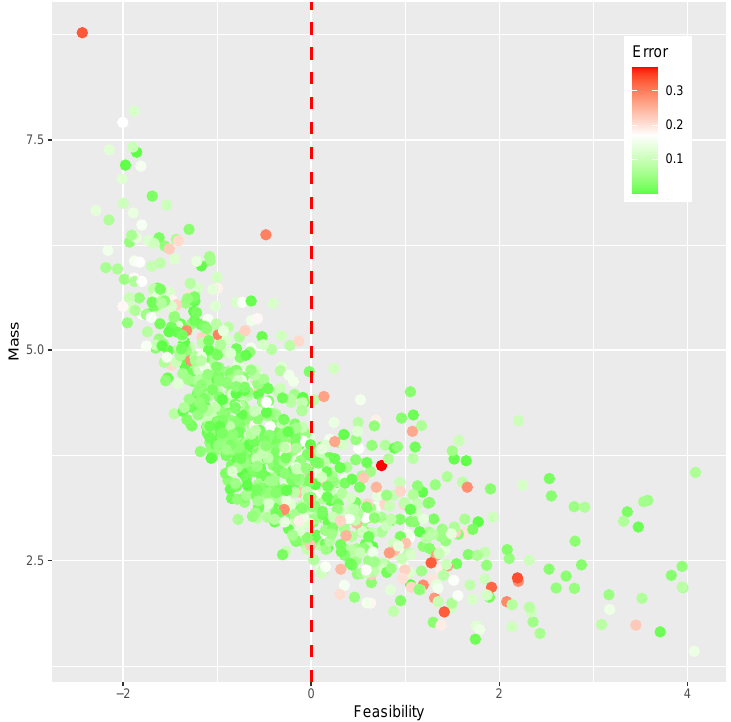
Figure 16. Mass error level | ∆ 1 | at several mass and feasibility values.